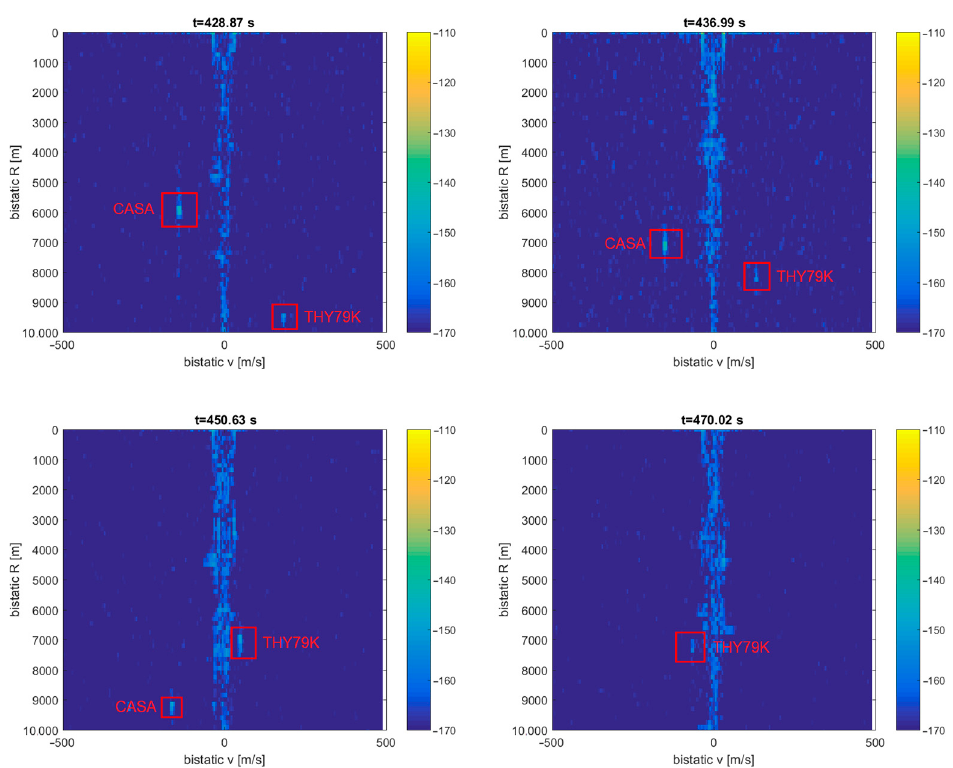
Figure 25. Detection results of the THY79K and CASA airplanes (subsequent time stamps).